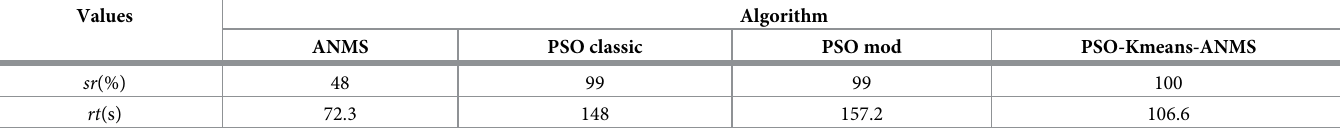
Table 7. Case 1 (100 × 20). Results of the success rate ( sr ) and average execution time ( rt ) of each optimization algorithm. Values